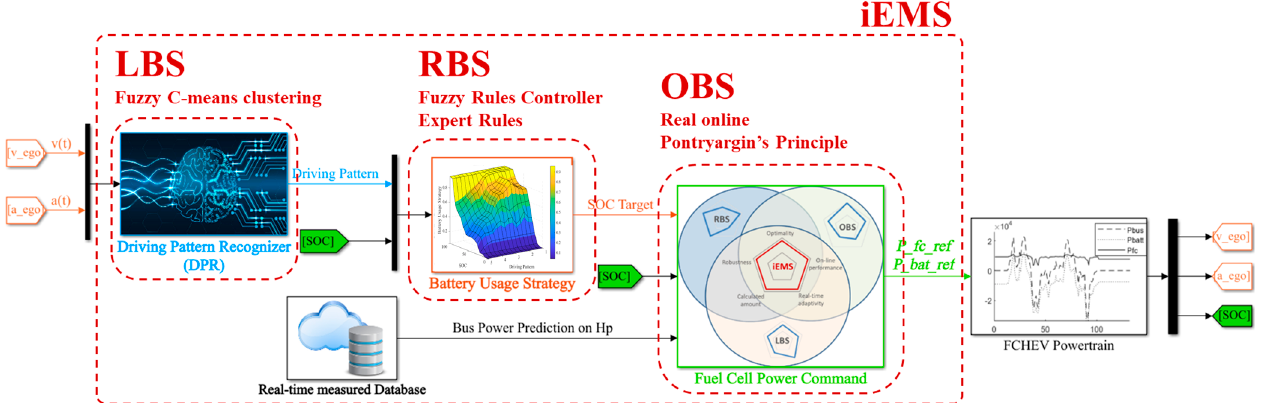
Figure 5. Proposed iEMS global architecture.